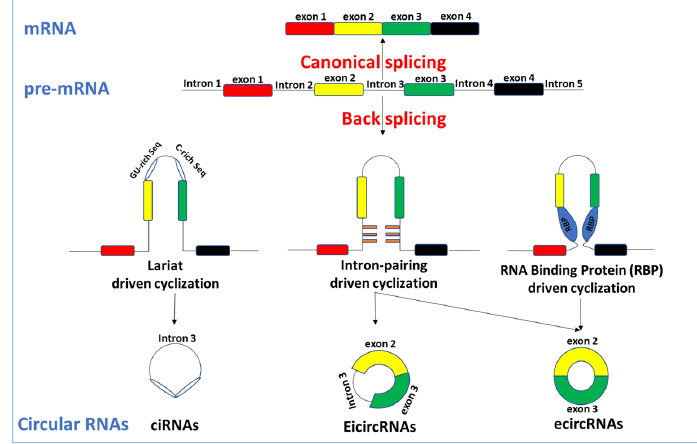
Figure 1. The cyclization forms of circular RNAs. A gene produces linear messenger and circular RNAs through two different splicing methods. The cyclization forms of circular RNAs are described in detail in the text. (i). Lariat-driven cyclization forms ciRNA. (ii). Intron-pairing-driven cyclization forms EicircRNA. (iii). RNA-binding-protein (RBP)-driven cyclization forms ciRNA. In this diagram of the cyclization forms of circular RNAs, exon 3 is associated with the upstream exon 2 rather than exon 4, as observed in linear splicing.